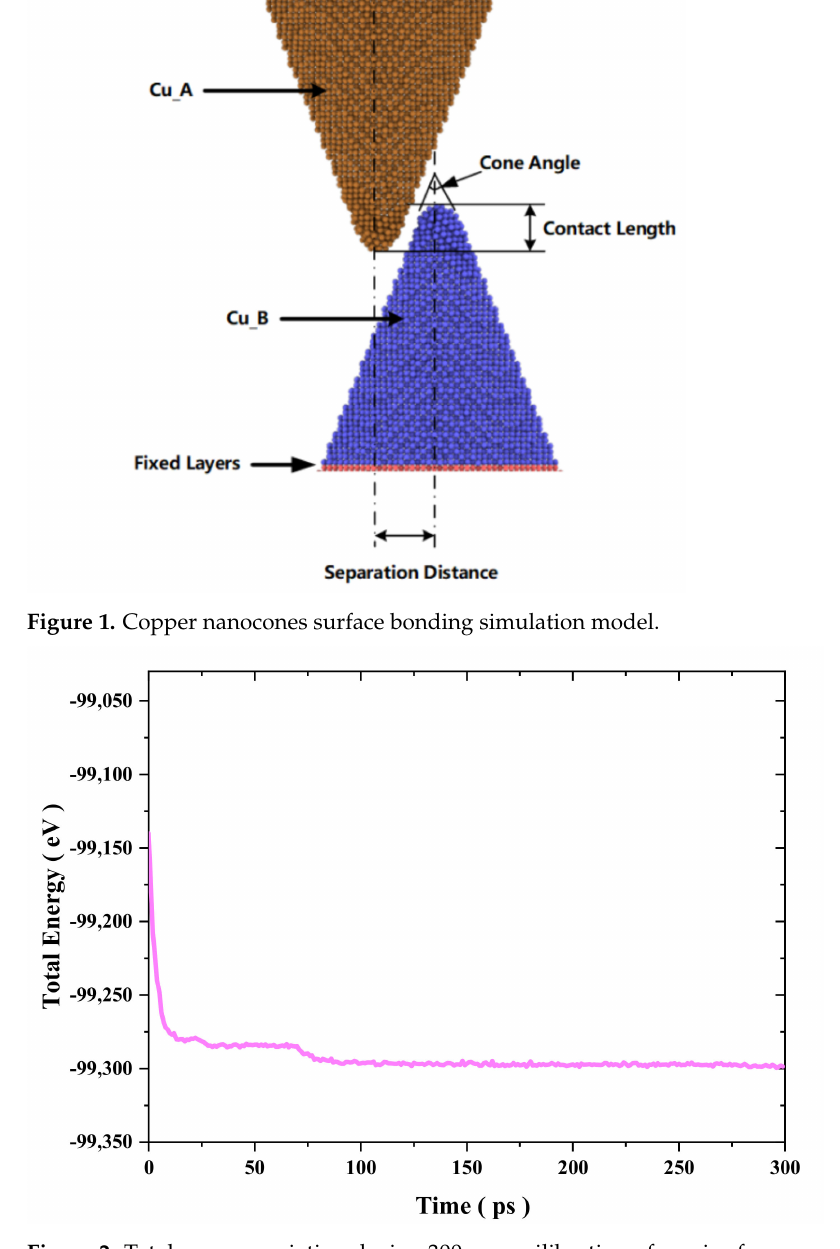
Figure 2. Total energy variation during 300 ps equilibration of a pair of nanocones, as oriented in Figure 1, with an initial axial separation of 20 Å and a contact length of 20